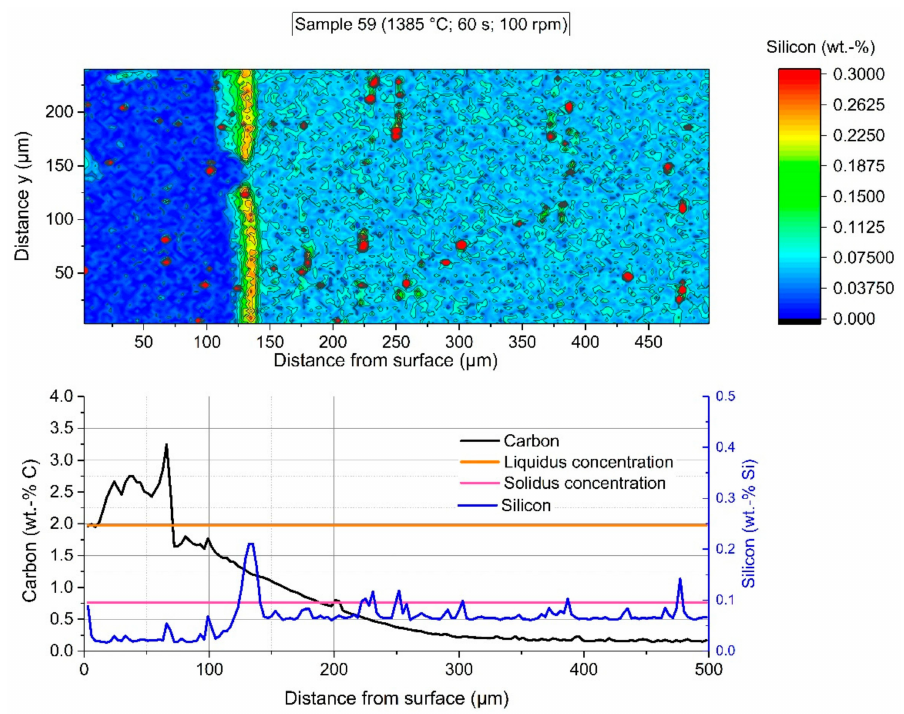
Figure 17. EPMA-measured silicon distribution of sample 59 with an immersion time of 60 s at 1385 ◦ C equilibrium temperature and turbulent bath